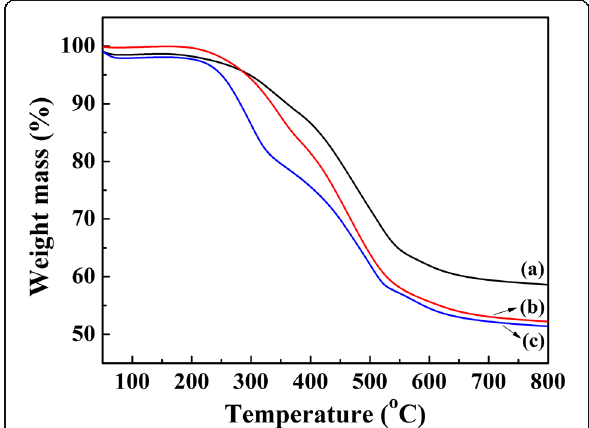
Fig. 1 TG curves of (a) TPDB, ( b ) TPDB-BP, and ( c) TPDB-BP-TEA. TPDB was found to be stable up to 300 °C as evidenced by TG (curve a). After the modification with BP and TEA, the thermos stability of the obtained samples TPDB-BP and TPDB-BP-TEA slightly decreased to 250